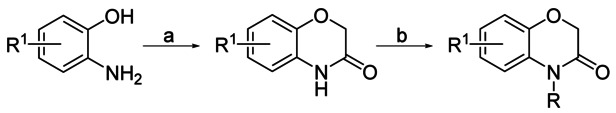
Benzomorpholinone synthesis. Reagents and conditions: a) 2-chloroacetyl chloride (1 equiv), 2-aminophenol (1 equiv), K2CO3 (1 equiv), DMF, 80 °C, 3 h; b) K2CO3 (1.4 equiv), DMF, 70 °C, 18 h; overall yield: 30–70 % (two steps).